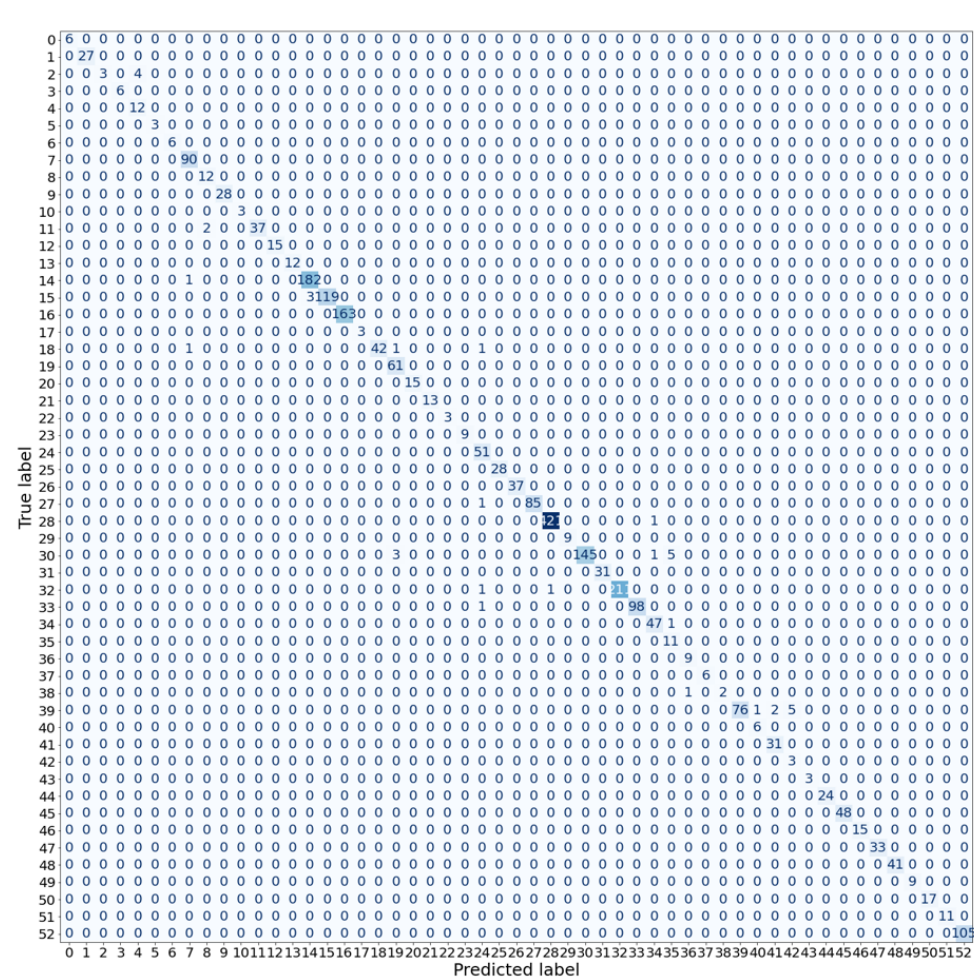
Figure 9. Confusion matrix of ensemble learning on the BTSD dataset.